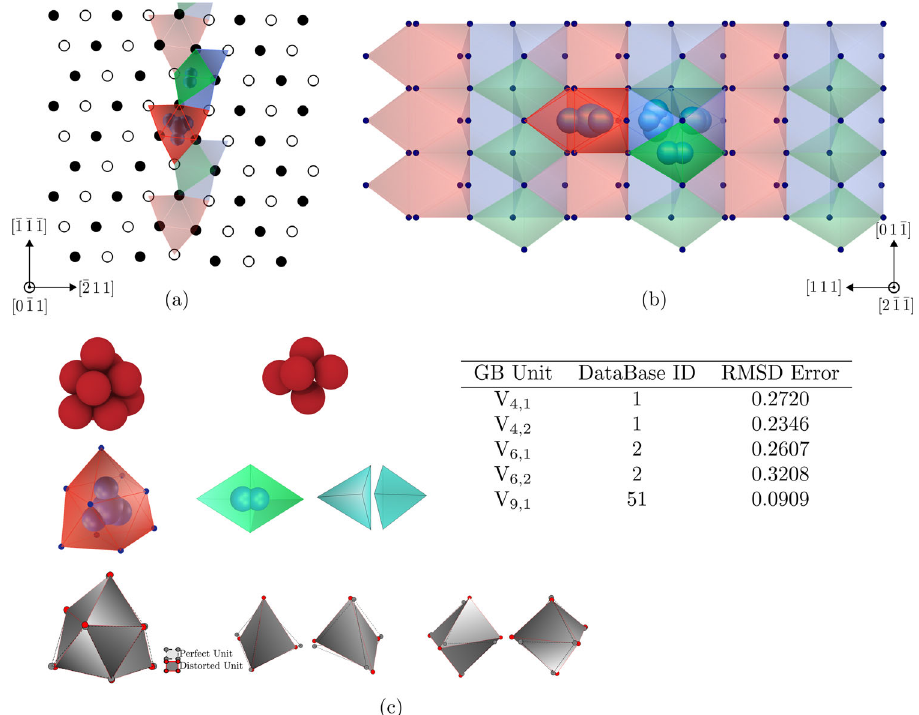
Fig. 8 The polyhedral unit model of the Σ 3 ð 211 Þ GB is illustrated. a , b The atomistic structure and the polyhedral units (CTPs, dual-tetrahedra and distorted octahedra) of the symmetric-tilt GB, along the tilt axis ½ 011 (cid:5) and the plane normal ½ 211 (cid:5) , are shown. The polyhedral units corresponding to the smallest asymmetric unit (the unit-cell) are highlighted. The registration of the fi ve unique polyhedral units with their corresponding model units is illustrated in c . The model units for the 9, 6 and 4-atom units are the capped-trigonal-prism, octahedron and the tetrahedron, respectively. In the table, these model units are identi fi ed according to their “ IDs ” in the data-base. The RMSD errors for these units are also provided